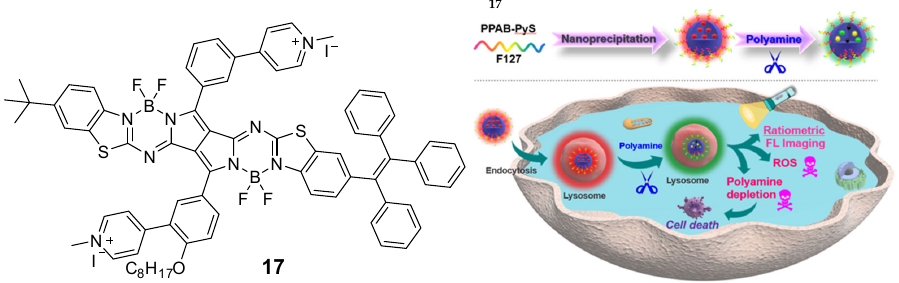
Figure 17. The combination of photodynamic therapy with a putative depletion of polyamines on cancer treatment with compound 17 [95].